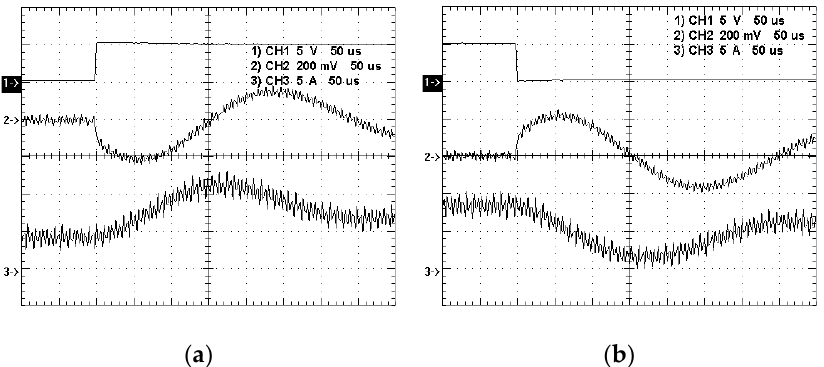
output voltage; (3) inductor current, due to ( a ) from 25% to 75%; ( b ) from 75% to 25%.